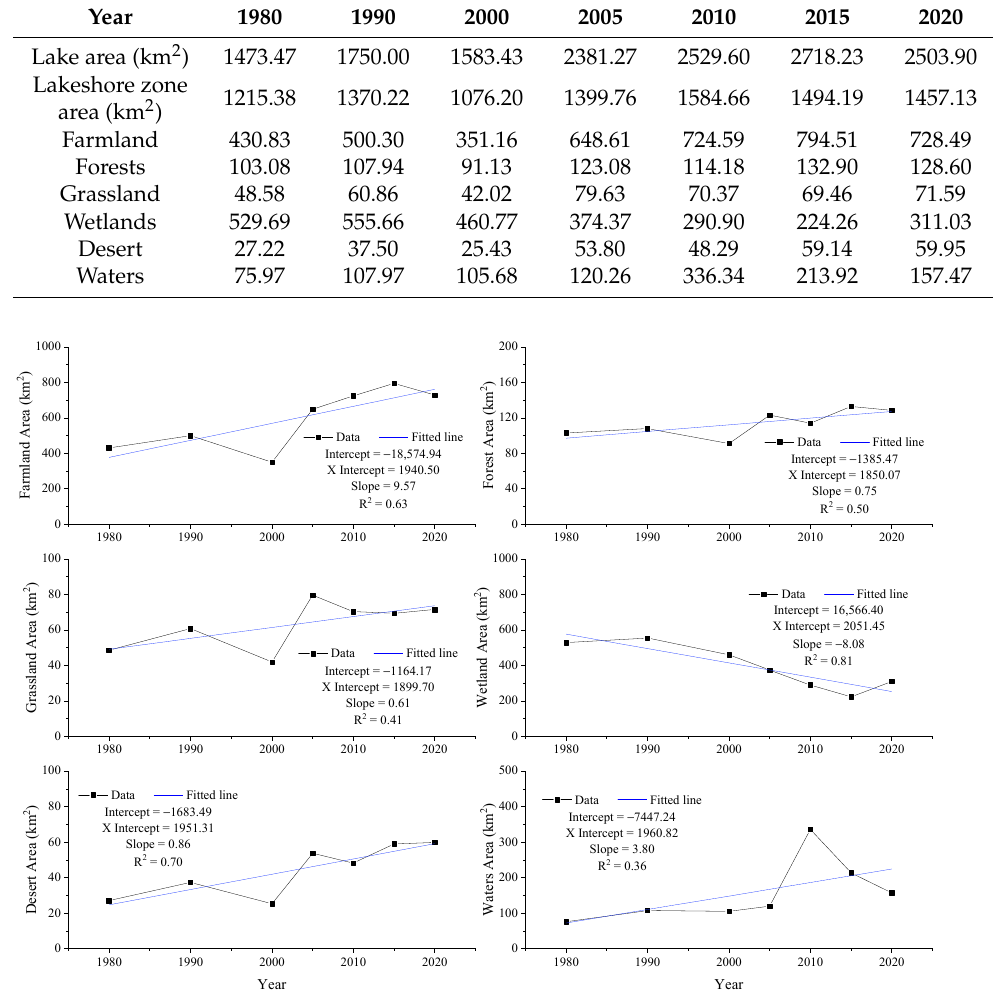
Figure 3. Values and trends of land use types at the level of the lakeshore zone of Poyang Lake from 1980 to 2020.